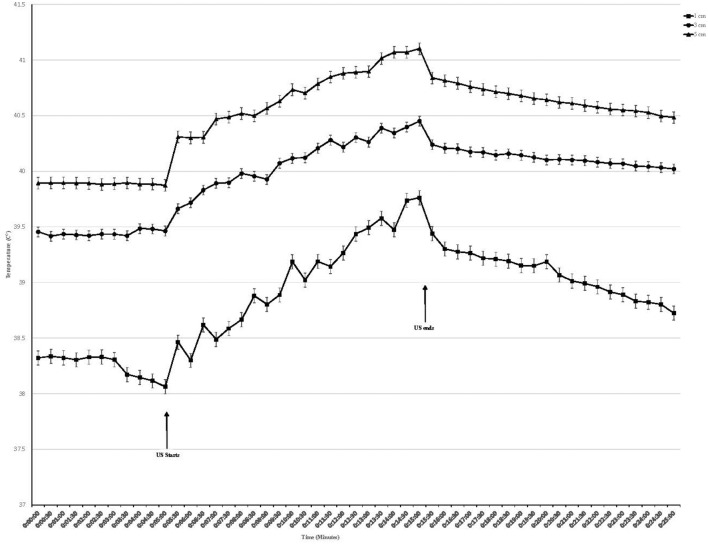
Tissue temperature change in epaxial muscles during therapeutic ultrasound at 1.0 W/cm2. Ultrasound starts at 5 min and ends at 15 min. Values presented as mean ± SEM.